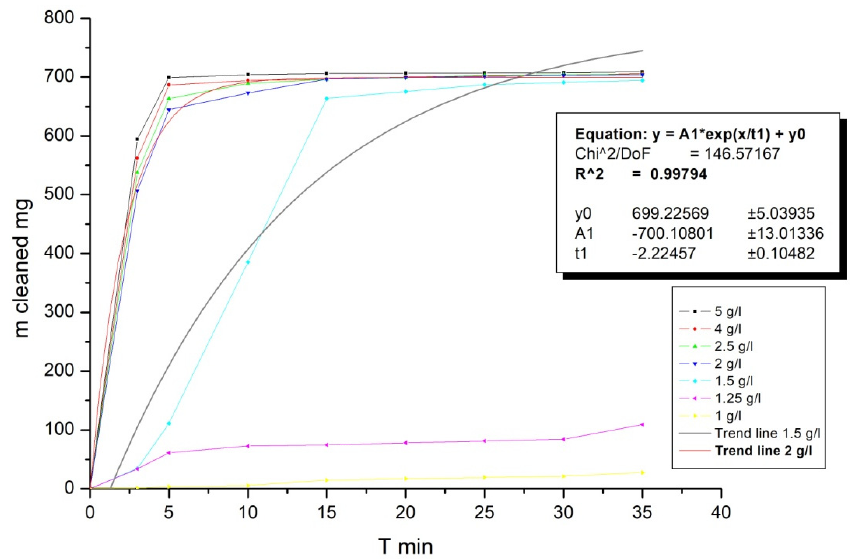
Figure 8. The concentration of suspended solids at different reagent dosages over time.